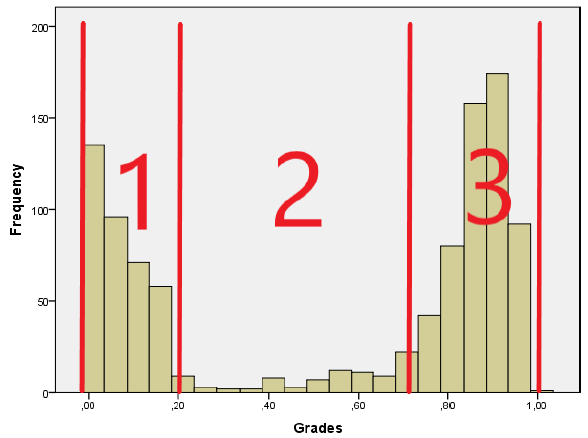
Figure 5. Categorization of the MOOC final grades in three